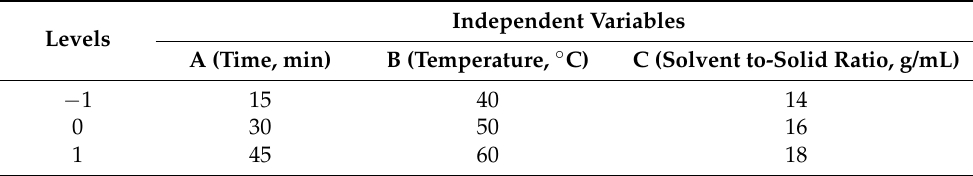
Table 3. Factors and levels of response surface analysis.